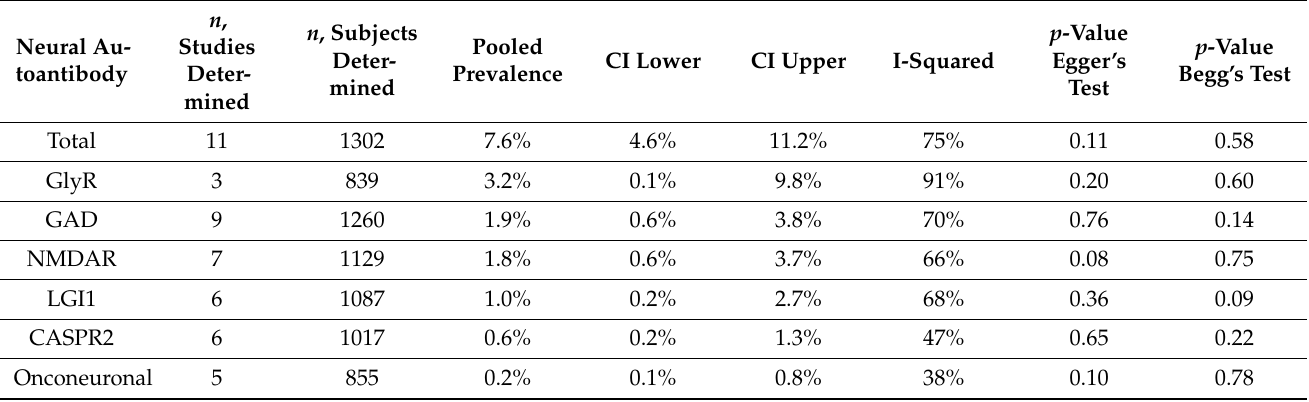
Table 2. The estimated pooled prevalence, the 95% confidence interval (CI), number of included studies and subjects, I2 as a measure for heterogeneity, p -value of the Egger’s test, and percentage of studies with low risk of bias for all meta-analyses.